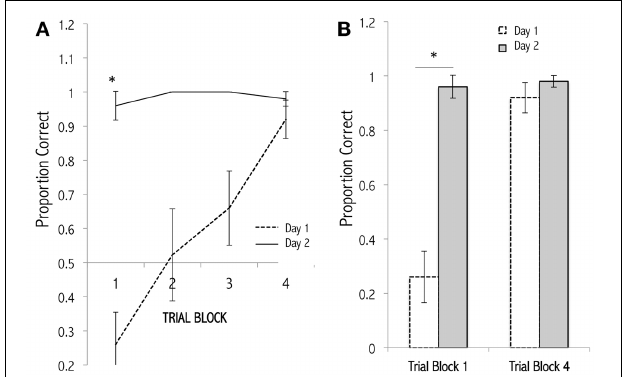
FIGURE 5 | Learning curves for an odor discrimination task. (A) Mice received 20 trials of discrimination training (Cleland et al., 2002) in which they learned to choose a rewarded conditioned odor (1.0 Pa) over a distractor odor (Day 1). Twenty-four hours later, the discrimination training was repeated (Day 2). The correct trials were scored and averaged across animals. Trials are grouped into 4 blocks of 5 consecutive trials for display and analysis. A steady improvement across trials on Day 1 is remembered 1 day later. (B) Data from trial blocks 1 and 4 replotted for comparison. Comparing trial block 1 (trials 1–5) between days, mice performed significantly better on the second training session, indicating a robust retention of odor memory [ asterisk : t (8) = 7 . 5593, p < 0 . 001]; no other comparisons approach statistical significance. Comparable findings have been observed by Schellinck et al.